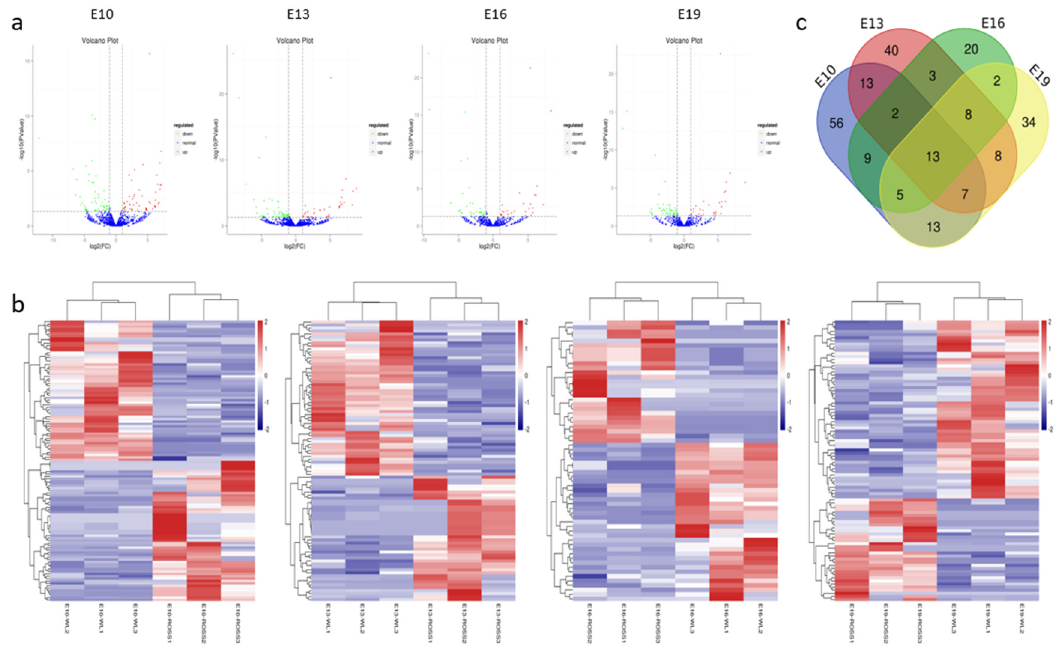
Figure 2. Characterization of the differentially expressed (DEMs). ( a ) The difference in expression levels of miRNAs between broilers and layers at different time points. ( b ) Heatmap of differentially expressed miRNAs in each paired group (broilers vs. layers). ( c ) Venn diagrams of DEMs in six comparison group ( n = 233; p < 0.05, fold change ≥ 2).